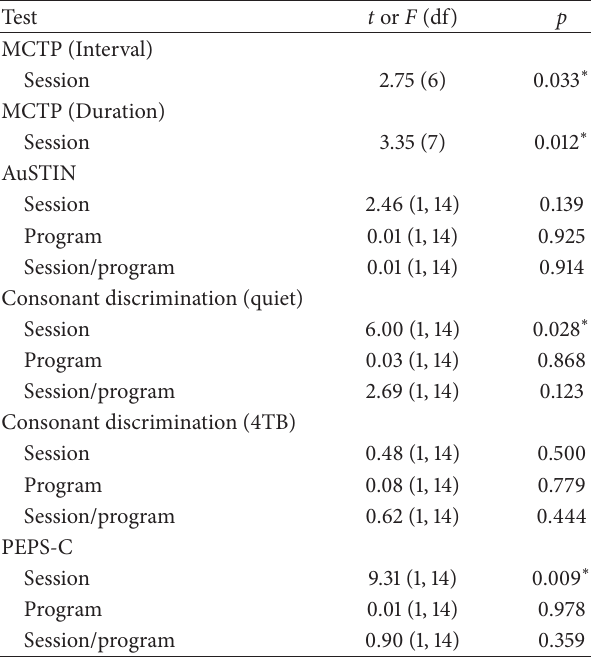
Table 2: Main effects of session, program, and interactions for all tests.